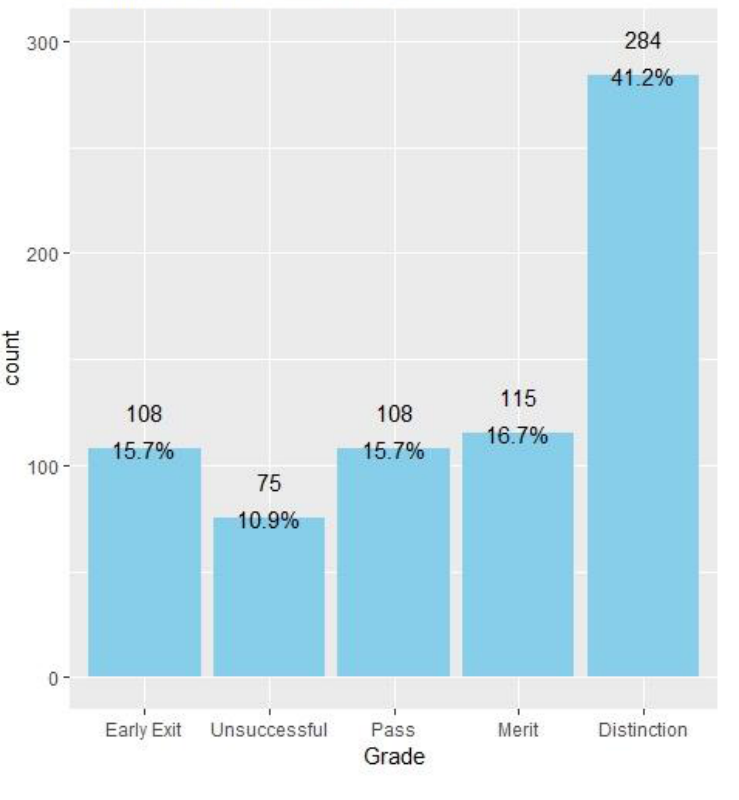
Figure 1: Distribution of